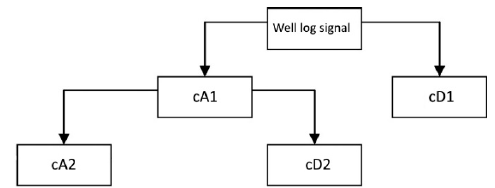
Figure 5. An illustration of the two-level decomposition of the well log signals.